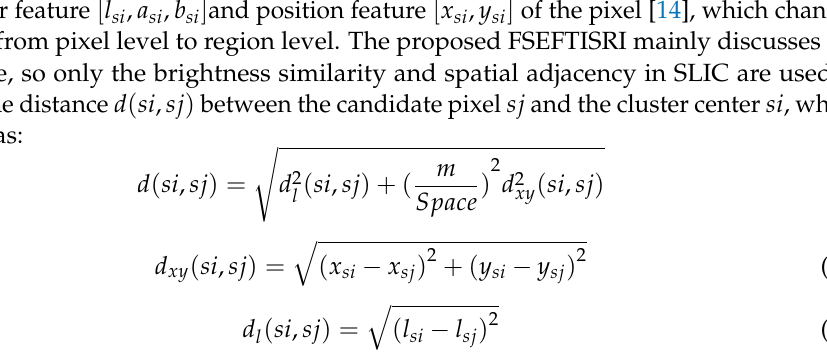
Figure 1. Flow chart of the proposed FSEFTISRI algorithm.